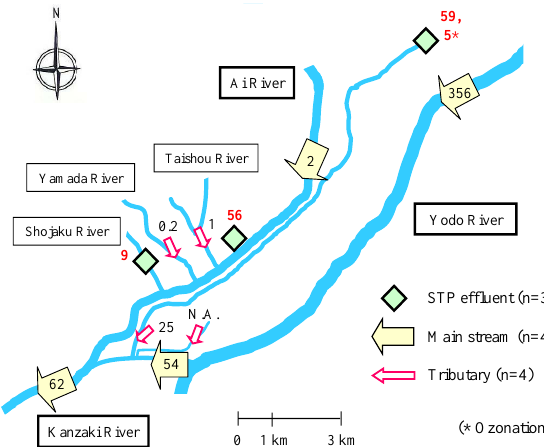
Figure 3. Source distribution of anticancer drugs in the Kanzaki–Ai River basin (abbreviation of each anticancer drug is shown in Table 1) (reproduced from [30]).